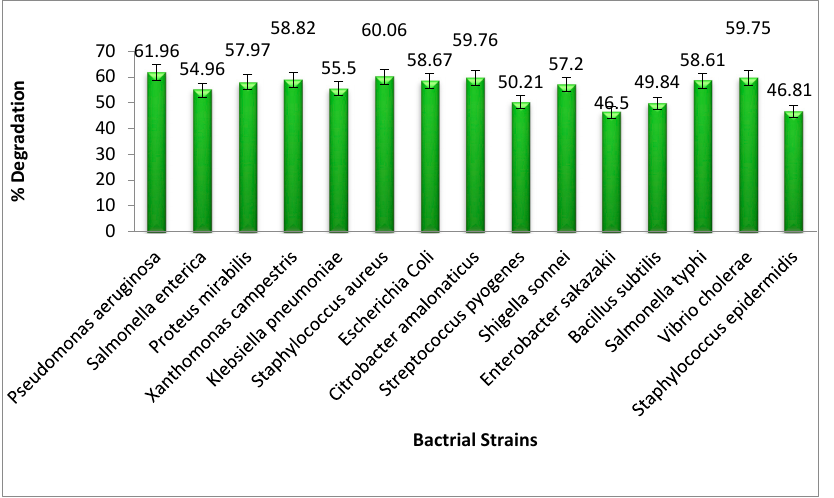
Figure 2. Different bacterial strains were used for the degradation of methyl orange (at neutral pH, 37 °C, 20 ppm of dye, 15 mL of nutrient broth, and an inoculum of 10 8 –10 9 CFU/mL of bacteria were cultured for three days).